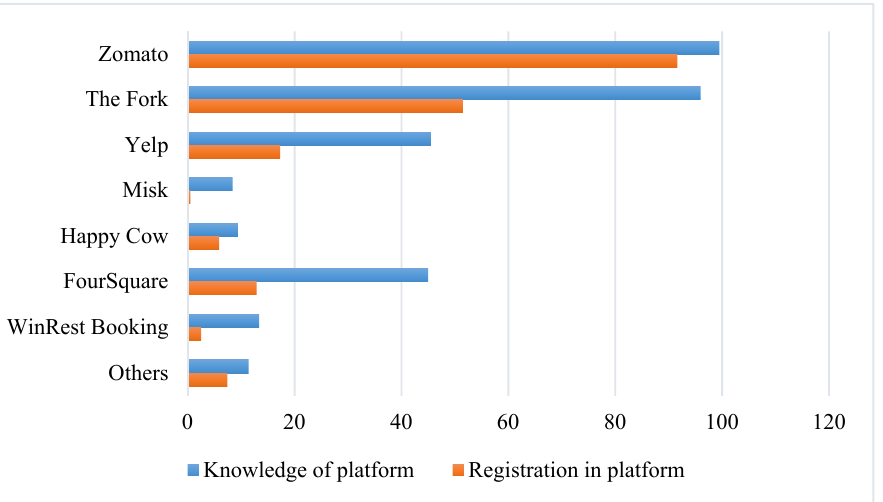
Figure 5. Platforms that managers know and platforms in which the firm is registered (%). This data encompasses firms that registered their establishment in TripAdvisor.